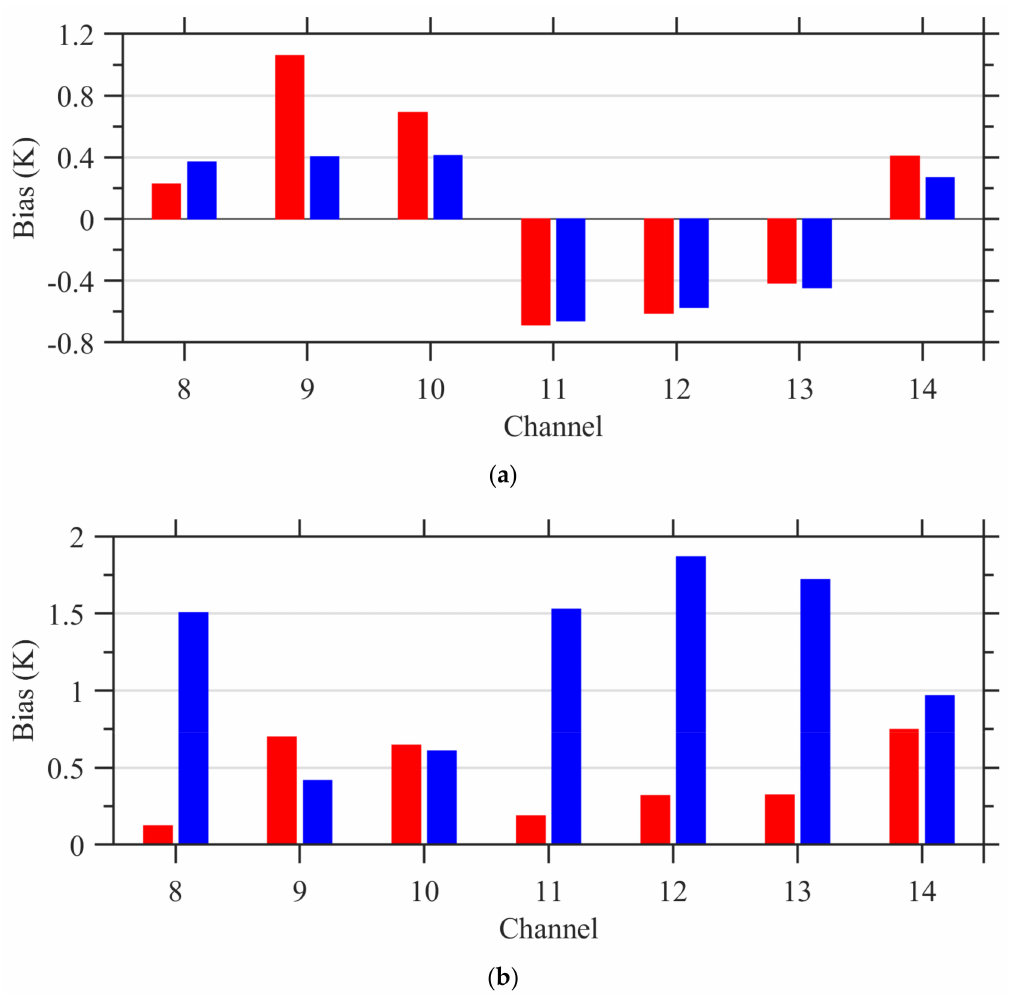
Figure 12. Mean biases of AGRI bands 8–14, calculated by OMB FNL (red) and OMB ERA5 (blue) statistics for data ( a ) over the ocean and ( b ) over land in January, April, October, and July 2019,